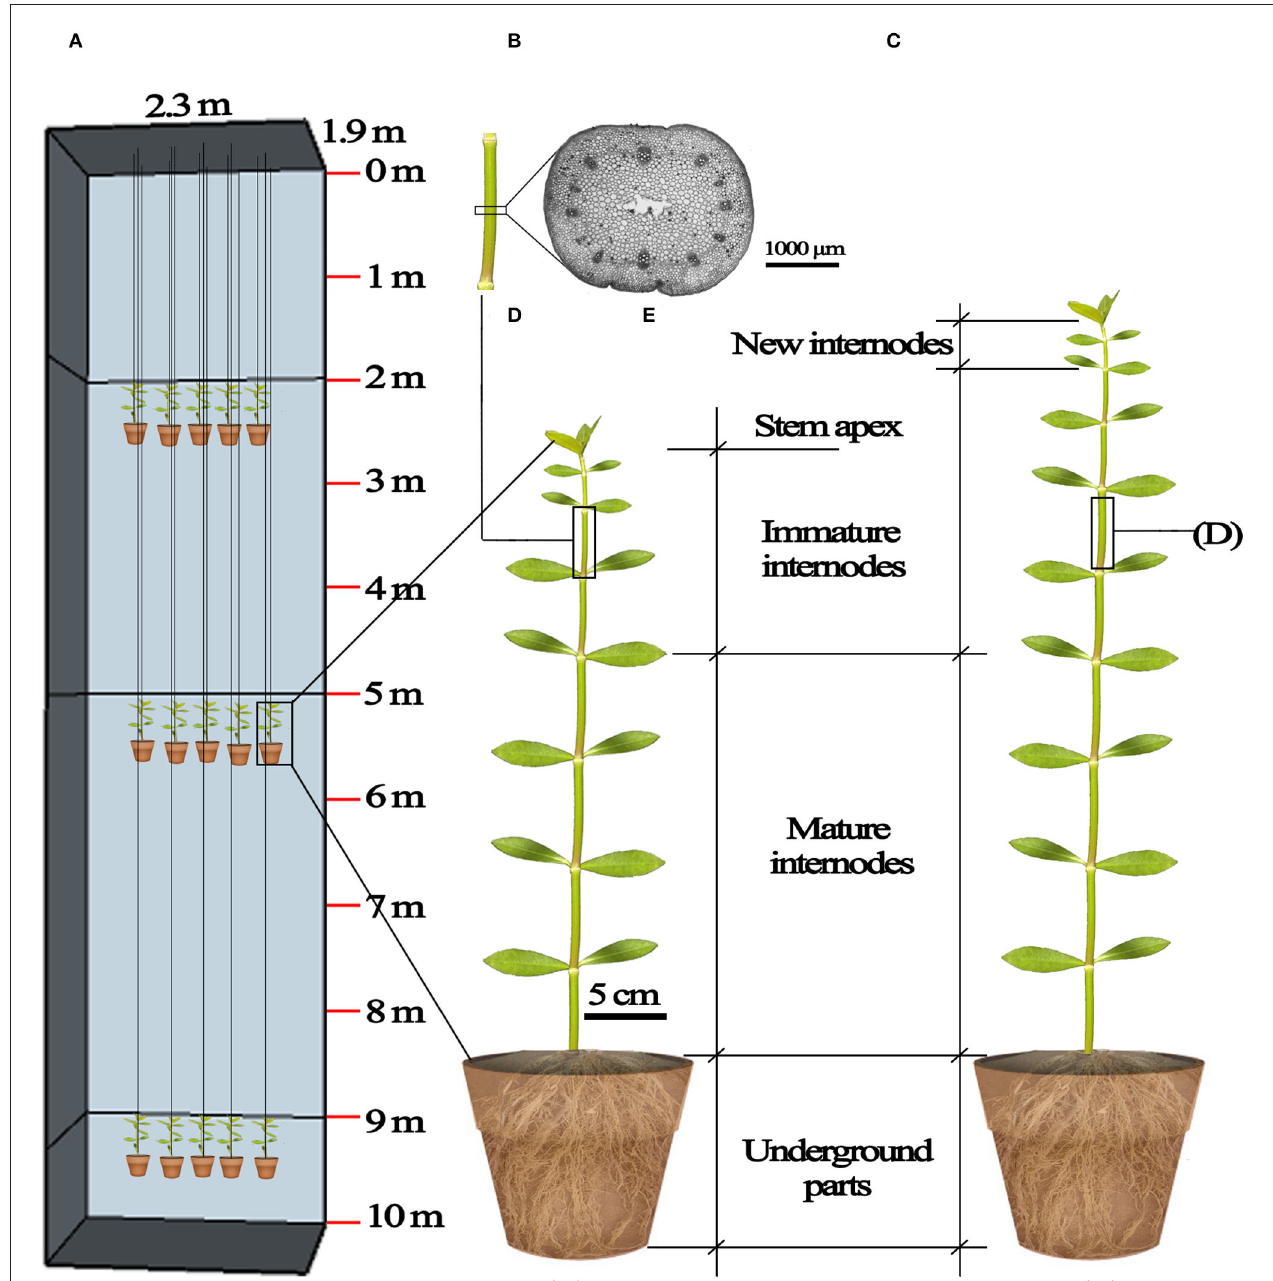
FIGURE 1 | Diagrammatic representation of the submergence design and plant material. (A) The frame of the 10m deep concrete reservoir (length × width × depth = 2.3m × 1.9m × 10m) and the 2, 5, and 9m submergence treatments; (B) underground parts, mature internodes, immature internodes and stem apex of A. philoxeroides before submergence treatments; (C) underground parts, mature internodes, immature internodes, new internodes, of A. philoxeroides after submergence; (D) the middle part of an internode, marked before treatments and used for making transverse sections at the end of submergence; (E) a transverse section of the